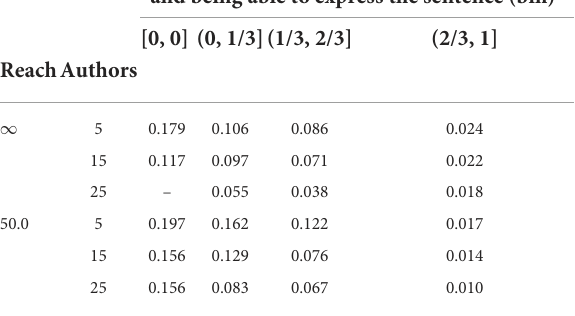
TABLE 1 Mean squared deviation (MSD) between a model’s degrees of belief and the underlying society’s sentence-wise vote ratios. Proportion of authors holding a belief about